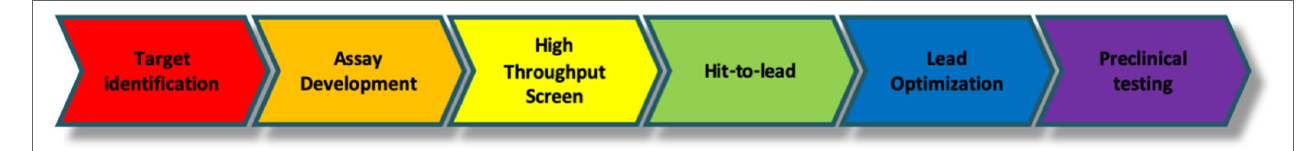
FIGURE 1 | Schematic representation of the preclinical drug discovery process. The preclinical drug discovery process can generally be divided into six unique steps from target identification to preclinical